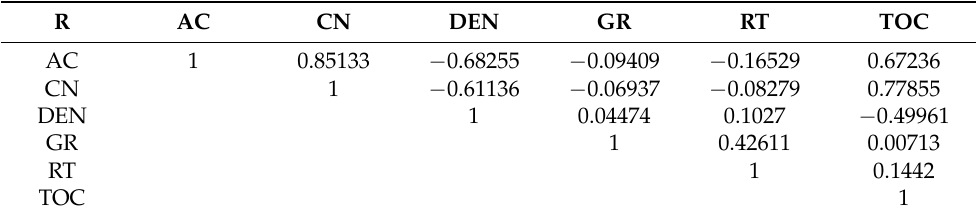
Table 1. Data of Pearson’s correlation